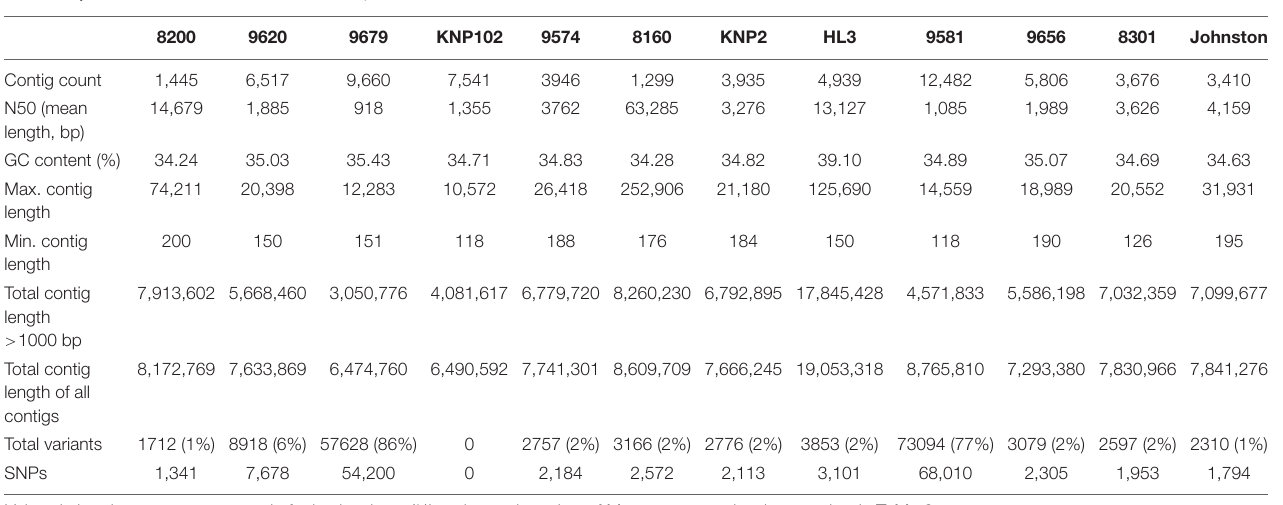
TABLE 4 | Genome features of South African T. parva